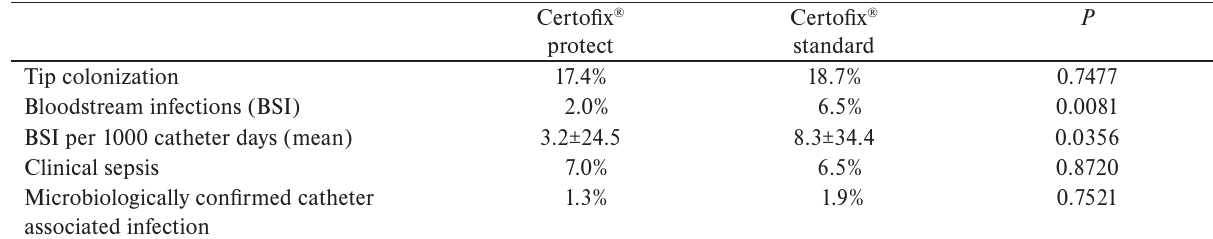
Table 3. Infection parameters in the Certofix ® protect and Certofix ® standard group.